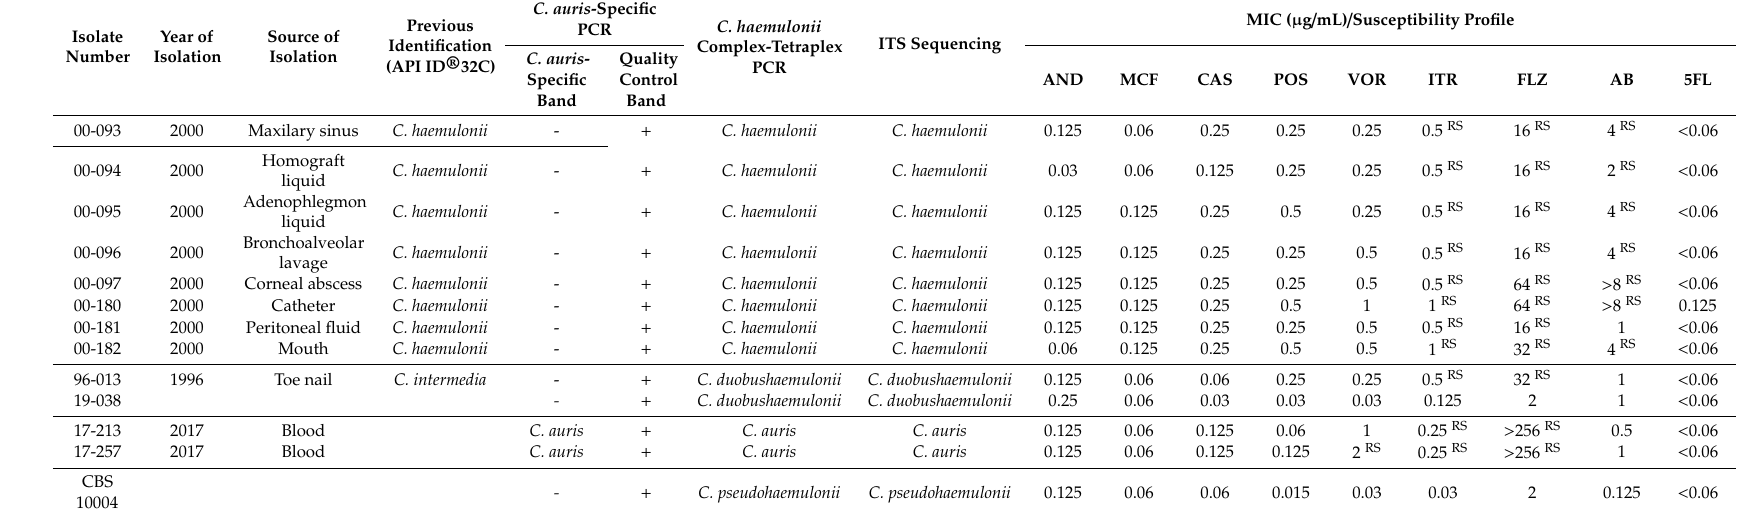
Table 2. Profiles of identification and susceptibility of clinical and control isolates of C. haemulonii complex against nine antifungal